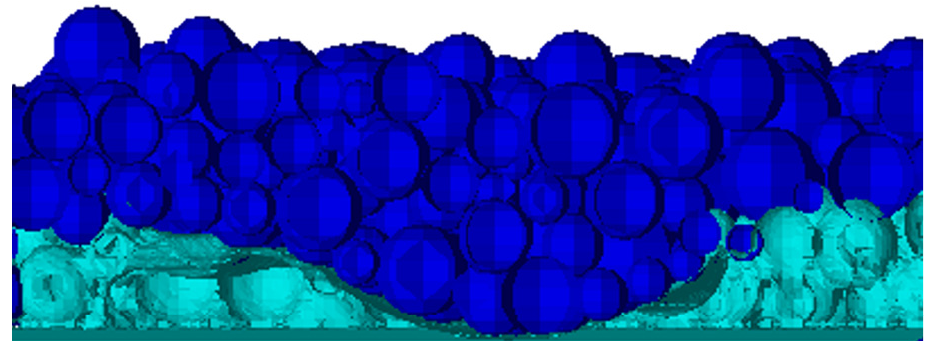
Figure 16. Variation in the actual powder layer thickness due to the variation in the surface height of the substrate layer.